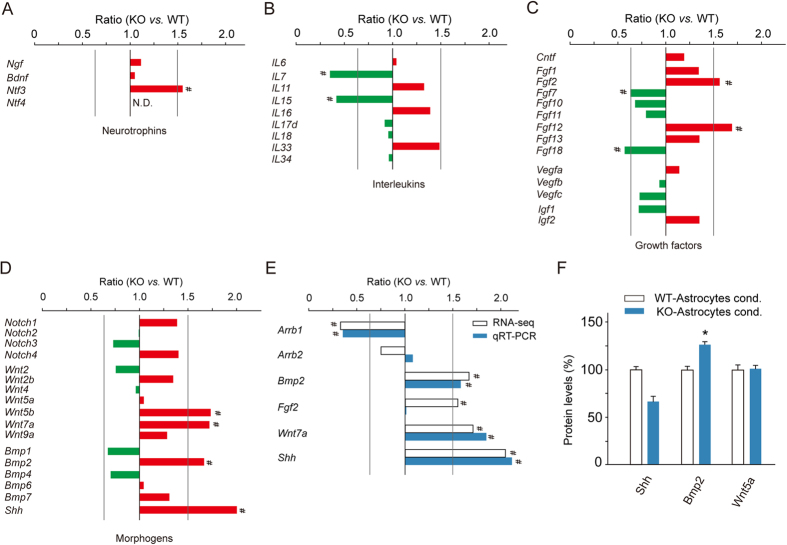
RNA-Sequencing Transcriptome Shows Abnormal Gene Profiles in β-arr1 KO Niche Astrocytes.(A–D) Changes of mRNA levels of different genes in WT and KO niche astrocytes determined by RNA-seq; (E) Comparison of mRNA levels of neural factors in WT and KO niche astrocytes determined by RNA-seq and qRT-PCR; Samples were collected from three mice in each group; # indicates ratio of β-arr1 KO vs. WT >3/2 or <2/3. (F) Protein levels of SHH, BMP2, and WNT5a in KO and WT astrocyte-conditioned media determined by ELISA. n = 3 independent experiments. Data were normalized to WT and represented mean ± s.e.m.; *p < 0.05 vs. WT; t-test.